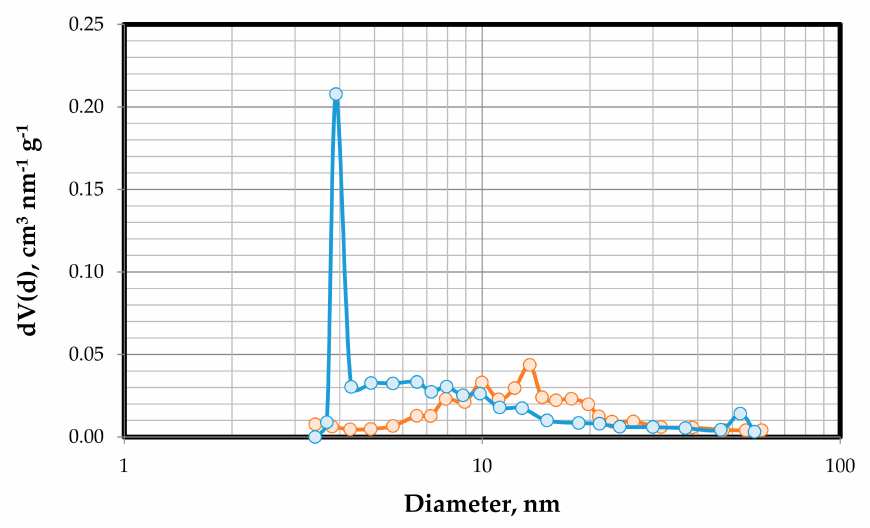
Figure 7. Pore size distributions of the catalyst ( ) as-synthesized; ( )